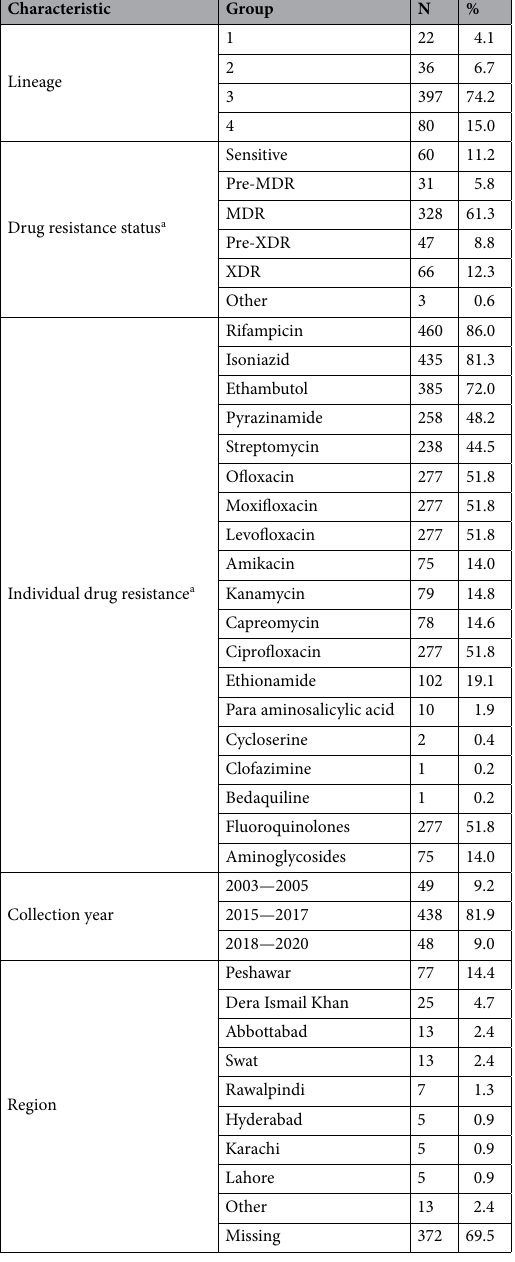
Table 1. Mycobacterium tuberculosis samples (N = 535). a Genotypic prediction using